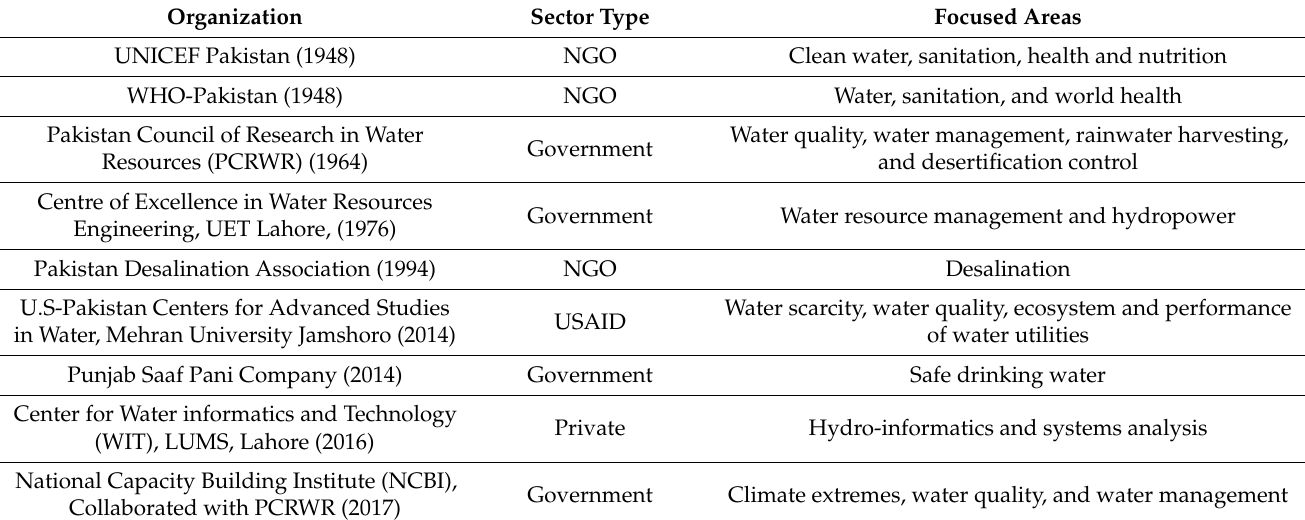
Table A3. Water research centers in Pakistan [43,69–76].